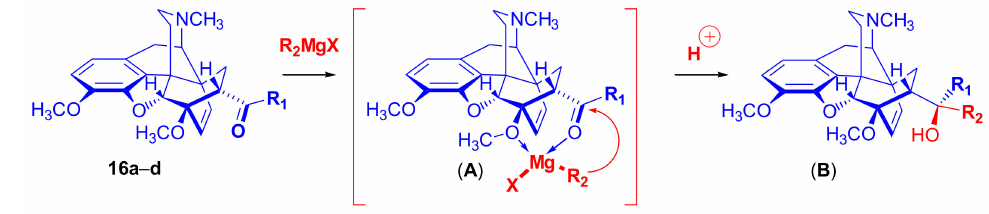
Figure 27. Mechanism of the normal Grignard addition of 7 α